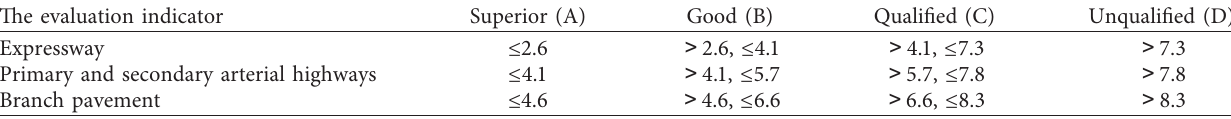
Figure 16: MTSS model prediction and actual error map. Table 6: Pavement performance evaluation